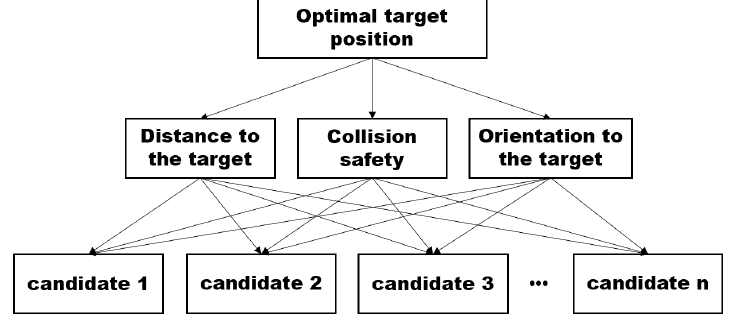
Figure 3. FAHP-based decision making